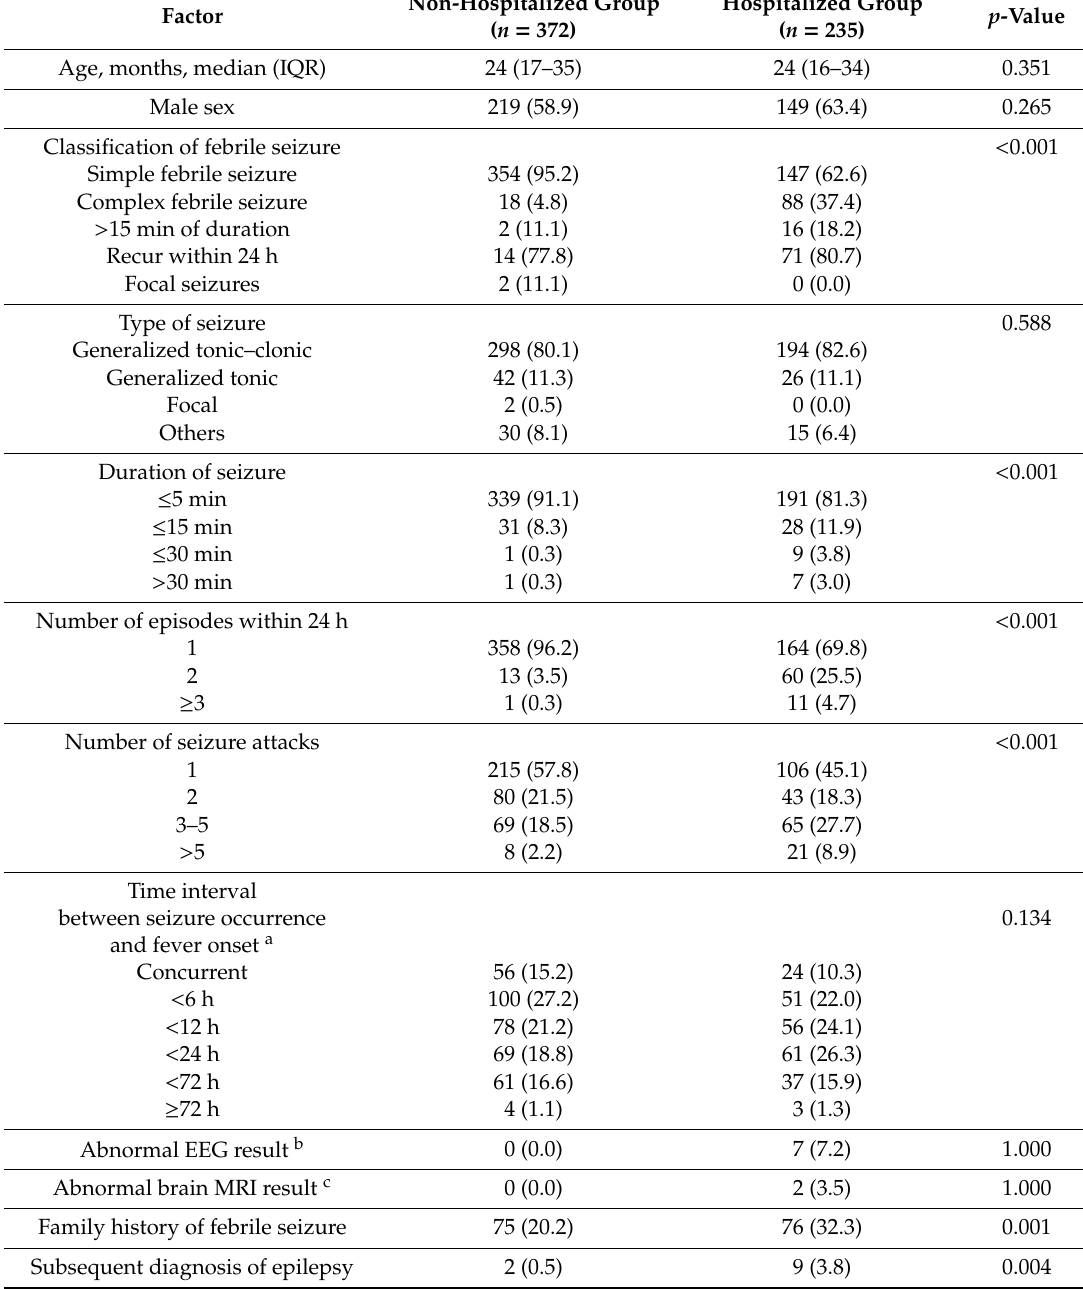
Table 1. Demographic and seizure characteristics of children presented with febrile